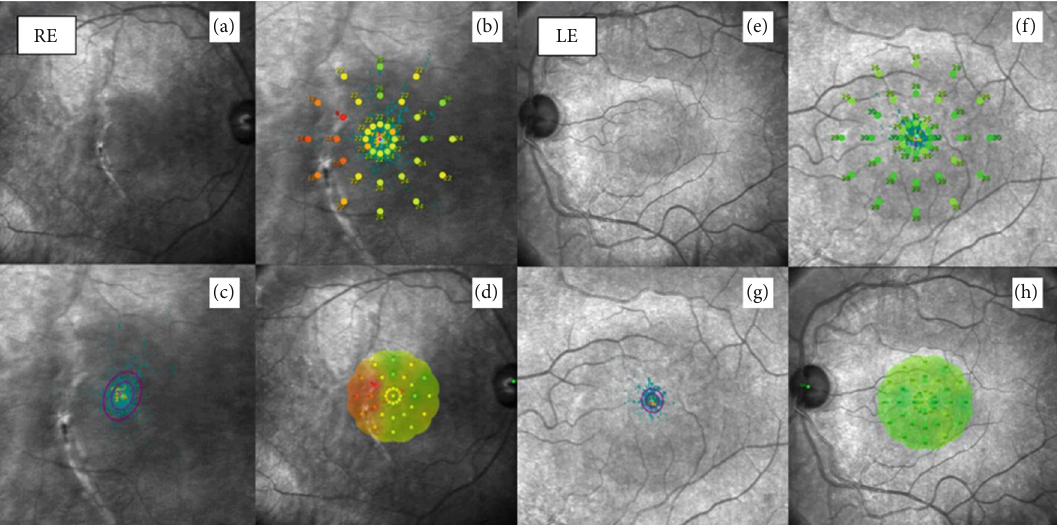
Figure 6: Comparative 6-month microperimetry. (a) The clinical aspect depicts a normal central fovea with a juxtafoveal choroidal rupture. (b) Retinal sensitivity measured with a microperimetry device (MAIA) shows a very diminished retinal sensitivity temporal to the fovea and an abnormal response 6 months following the surgery. The red fi gures and numbers indicate abnormally low retinal sensitivities (dB). (c) Stable foveal fi xation pattern of the a ff ected eye. (d) Corresponding foveal plotting with low retinal sensitivity on the temporal side of the fovea. (e – h) Correspond to normal left eye